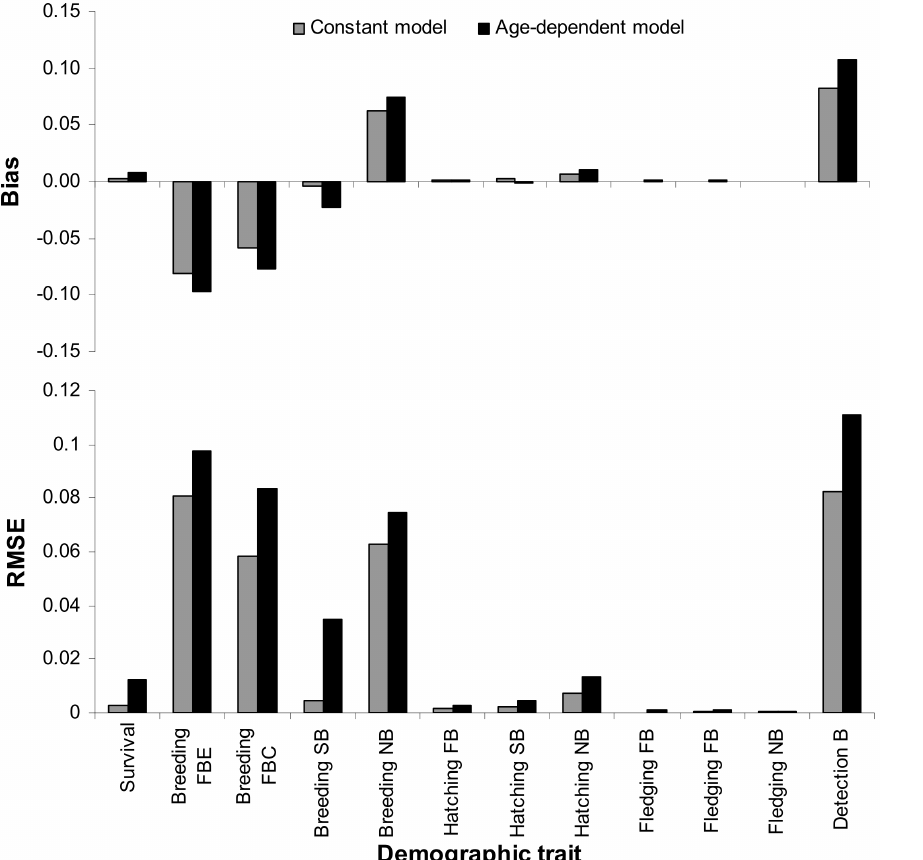
Figure 1. Comparison of bias and RMSE (Root Mean Square Error; ± SE) between constant and averaged age-dependent models on five demographic traits (survival, breeding, hatching, fledging and detection probabilities) taking into account the previous breeding state: F=Failed, S=Successful, B=Breeder, E=Egg, C=Chick, NB=Non-Breeder. As opposed to the MSM_ONB capture- recapture model, the information brought by the Observed Non-Breeders is not taken into account in the MSM capture-recapture model.. The exact same model structure was used for MSM_ONB and MSM capture-recapture models.